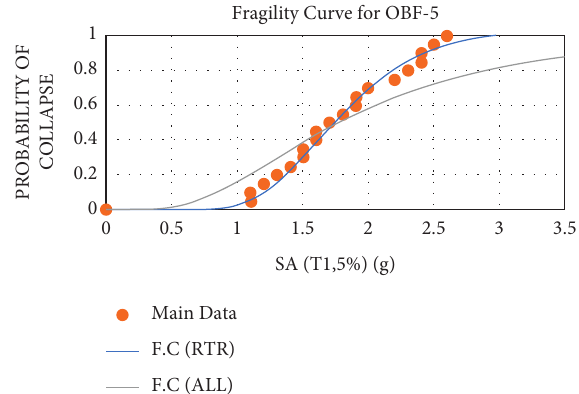
Figure 23: Fragility curves of OBF-5 frame with all